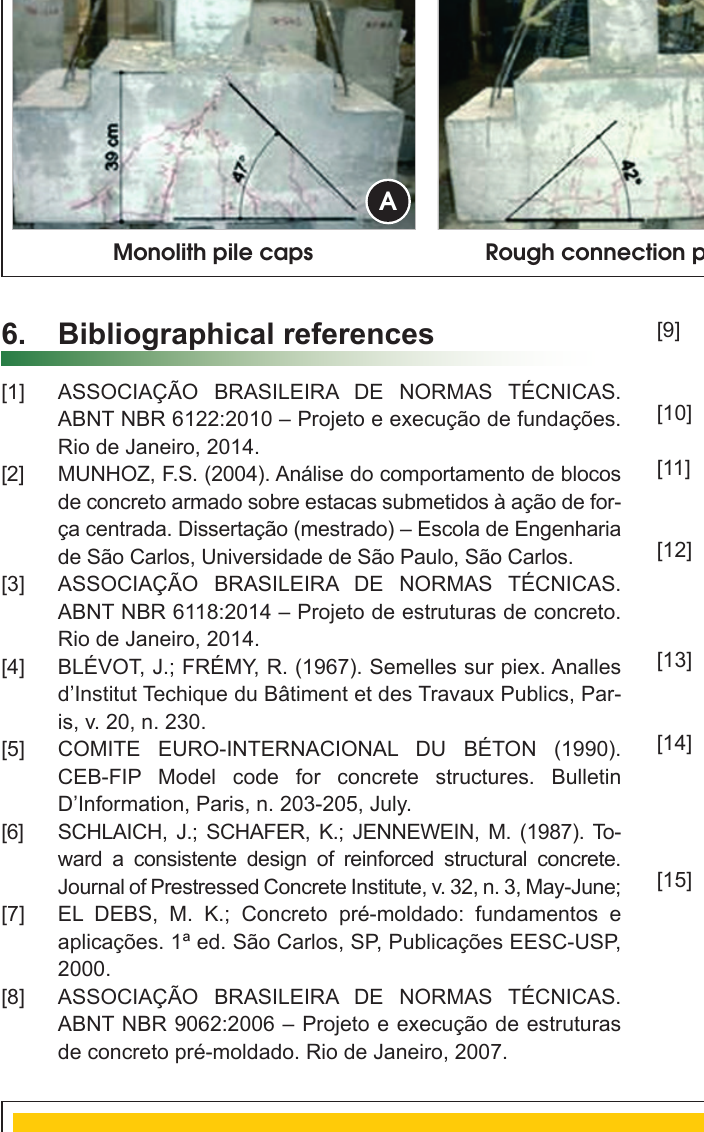
Table 5 – Forces on tie reinforcement bars